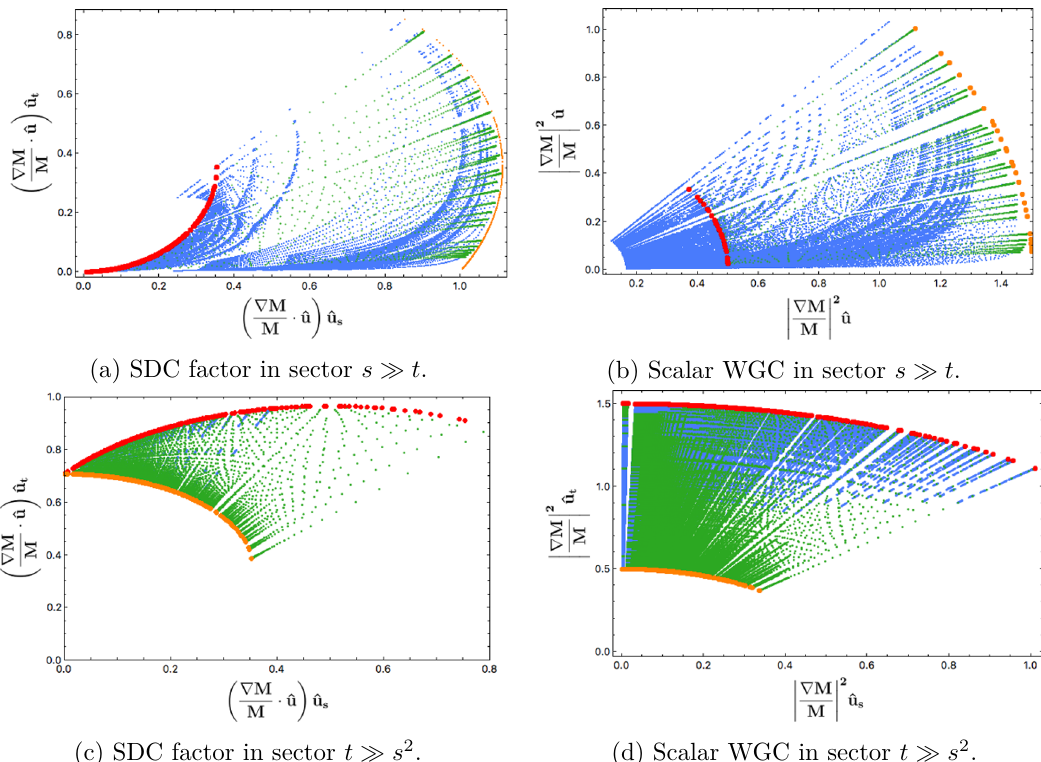
Figure 8. The SDC factor | λ | in each direction of field space, as well as the magnitude of the scalar WGC in each direction of field space. Blue points correspond to arbitrary sites in the quantized charge lattice. Green points correspond to points in the monodromy tower. Red points correspond to the seed charge of the monodromy tower. Orange points correspond to single-charge states that are not the seed charge. The first row shows the results for the growth sector s (cid:29) t , while the second row shows the results for the growth sector t (cid:29) s 2